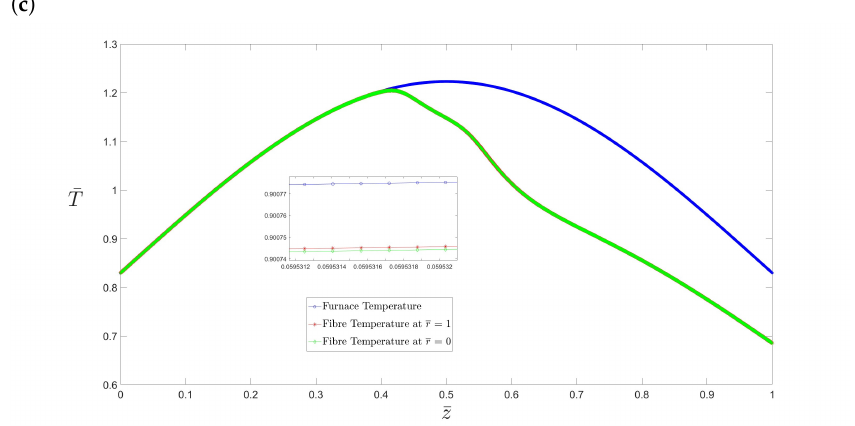
Figure 9. ( a ) Axial component of the velocity w against the axial distance z , with h 1 and h 2 plotted against the axial distance z in ( b ) and the temperature profiles of the inner and outer capillary surfaces and the temperature profile of the furnace plotted against the axial distance z in ( c ). The inset in ( c ) shows the difference among the temperature profiles.